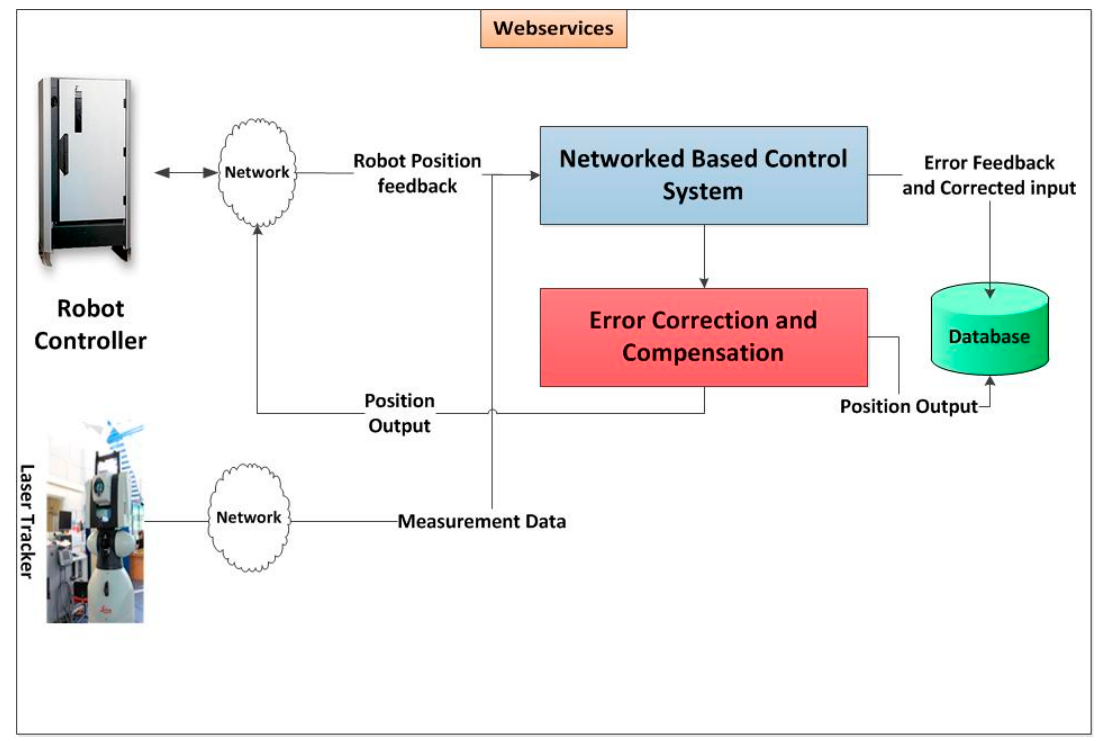
Figure 1. Basic system architecture.